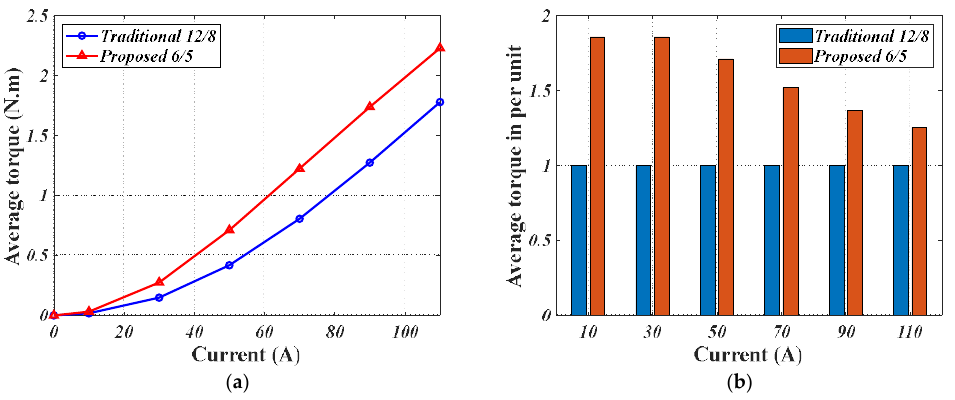
Figure 9. Average torque comparison in the two motors. ( a ) Average torque in absolute value; ( b ) Average torque in relative value.